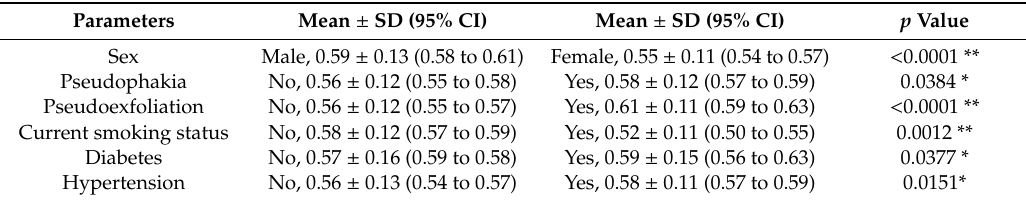
Table 4. Possible association among advanced glycation end products and various categorical